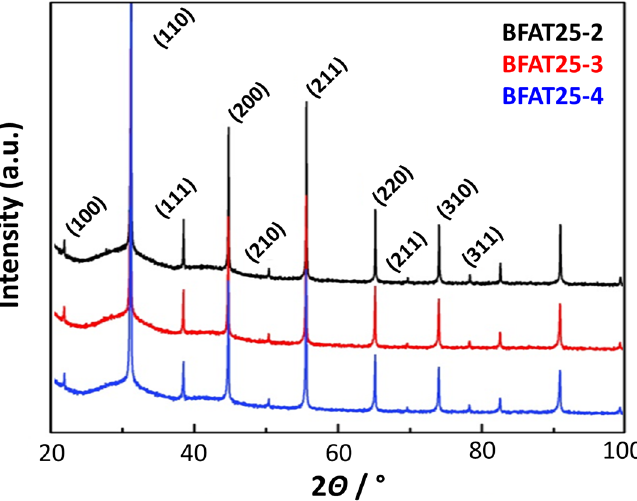
Figure 1. Diffraction patterns of the powder batches BFAT25-2, 3, and 4. Figure 1. Di ff raction pa tt erns of the powder batches BFAT25-2, 3, and 4.